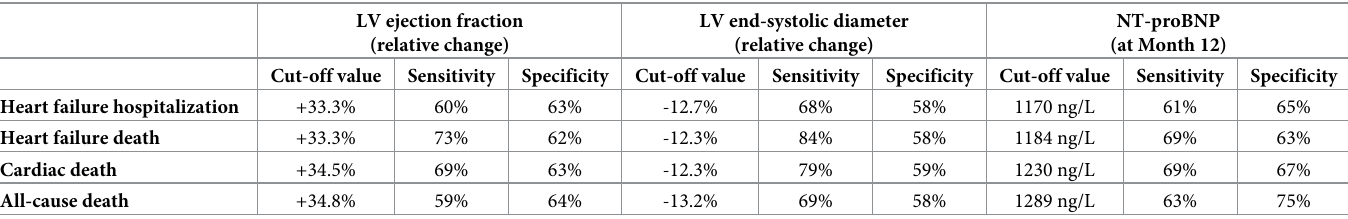
Table 6. Receiver-operating characteristics: Optimum cut-off values.